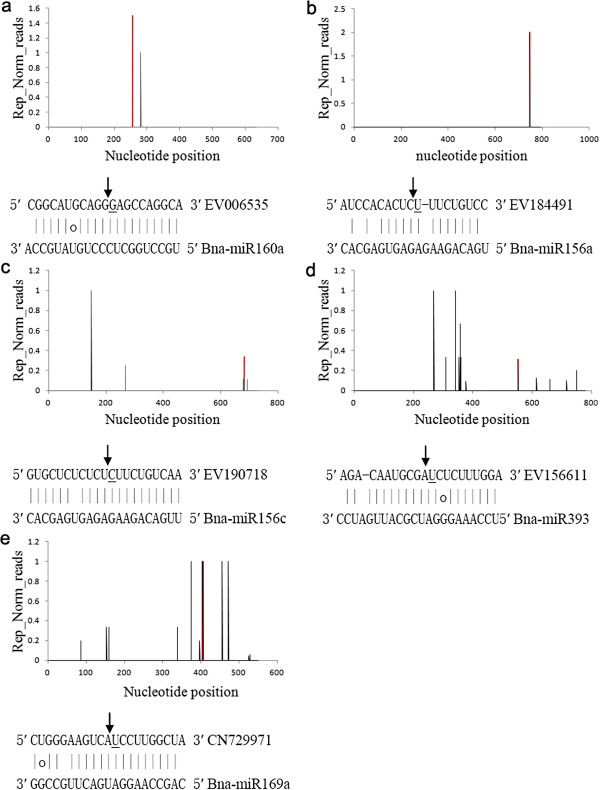
Confirmed microRNA (miRNA) targets using degradome sequencing are presented in the form of target plots (t-plots). We used normalized numbers in plotting the cleavages on target mRNAs, which were referred to as ‘target plots’ (t-plots) by German et al. [51]. Signature abundance throughout the length of the indicated transcripts is shown. Representative t-plots for class 0 (a), class I (b), class II (c), class III (d), and class VI (e) categories are shown. Arrows indicate signatures consistent with miRNA-directed cleavage. miRNA:mRNA alignments along with the detected cleavage frequencies (normalized numbers) are shown. The frequencies of degradome tags with 5′ends at the indicated positions are shown in black, with the frequency at position 10 of the inset miRNA target alignment highlighted in red. The underlined nucleotide on the target transcript indicates the cleavage site detected in the degradome.